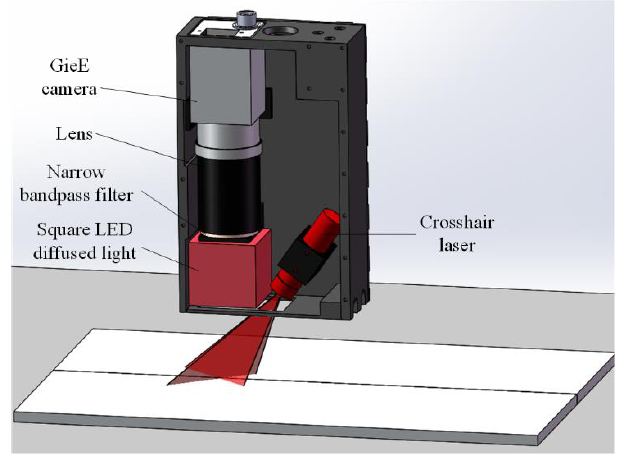
Figure 13. Configuration of the joint detection sensor.